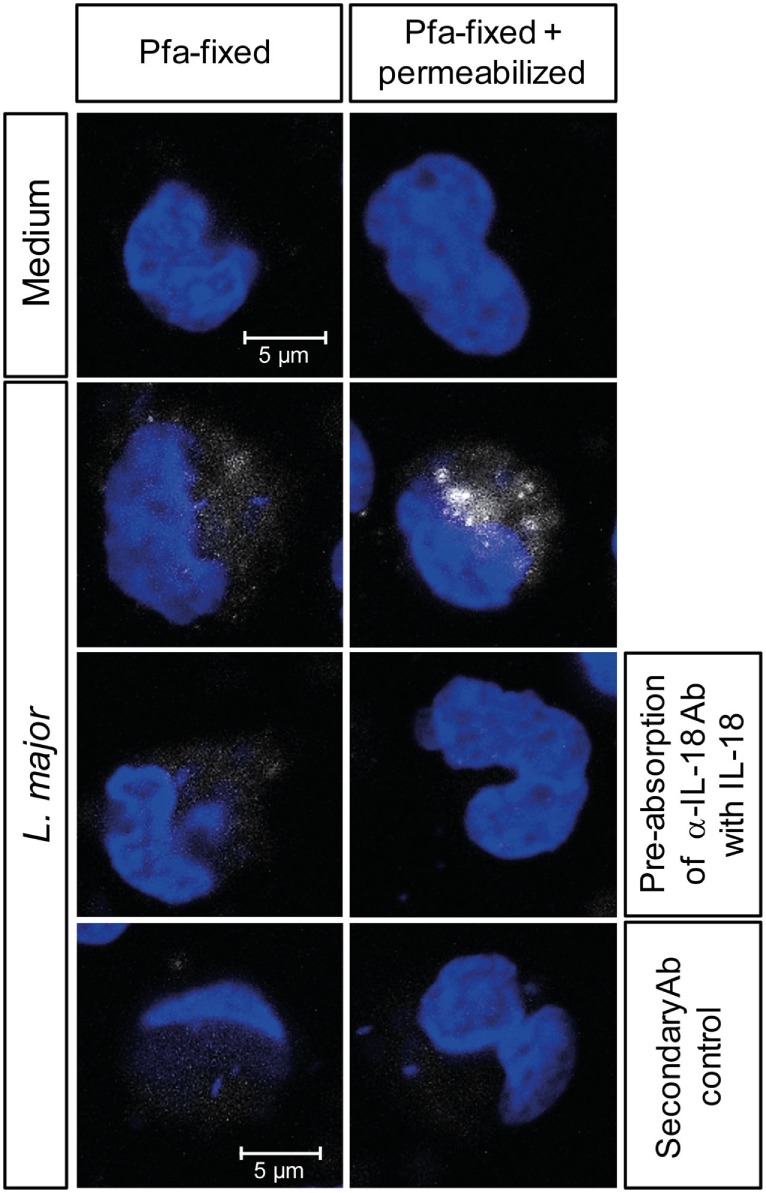
Interleukin (IL)-18 is detectable on fixed, but non-permeabilized monocytes after exposure to Leishmania. Purified CD14+ monocytes attached to an adhesion slide were incubated with or without Leishmania major promastigotes (multiplicity of infection 10) for 20 h. Thereafter, monocytes were either fixed with paraformaldehyde (Pfa) or fixed with Pfa and permeabilized with methanol, before being stained for IL-18 (white) and with DAPI (blue). As controls, the mouse-anti-IL-18 antibody (Ab) was pre-absorbed with rhuL-18, or the cells were incubated with the secondary Ab alone. Representative images of one of three independent experiments are shown.